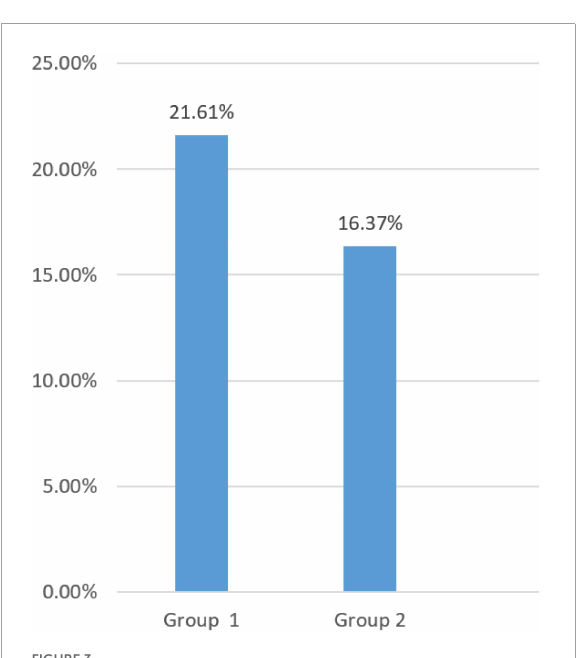
FIGURE3 Mean test result percentage increase (stage 1–stage 3) (author’s